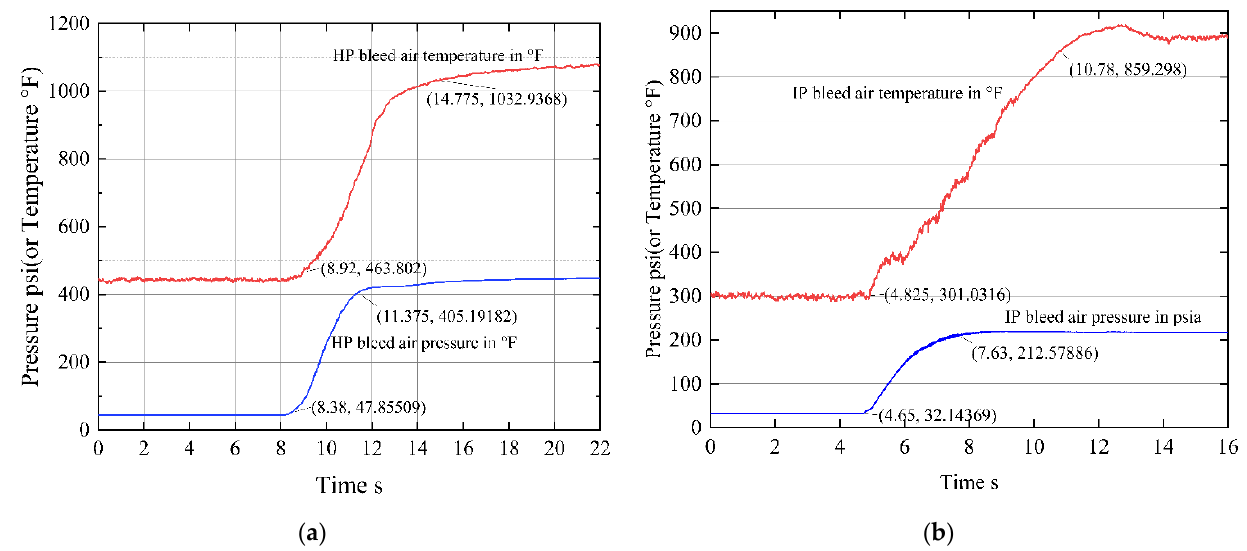
Figure 10. The HP and IP bleed air temperature and pressure rapid rise characteristics of the cooling-package-one on HPR. ( a ) The HP bleed air temperature and pressure rapid rise characteristics; ( b ) the IP bleed air temperature and pressure rapid rise characteristics.